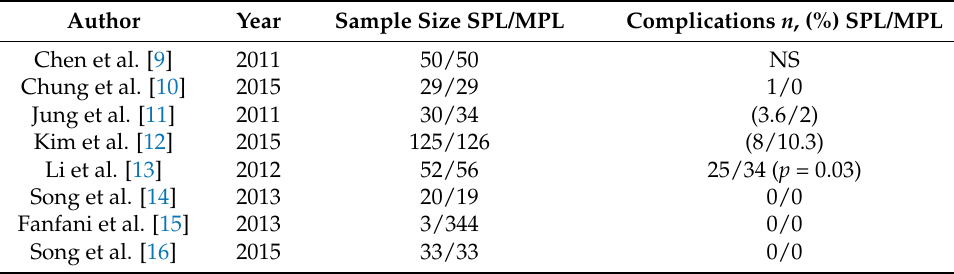
Table 1. RCTs about hysterectomy for benign